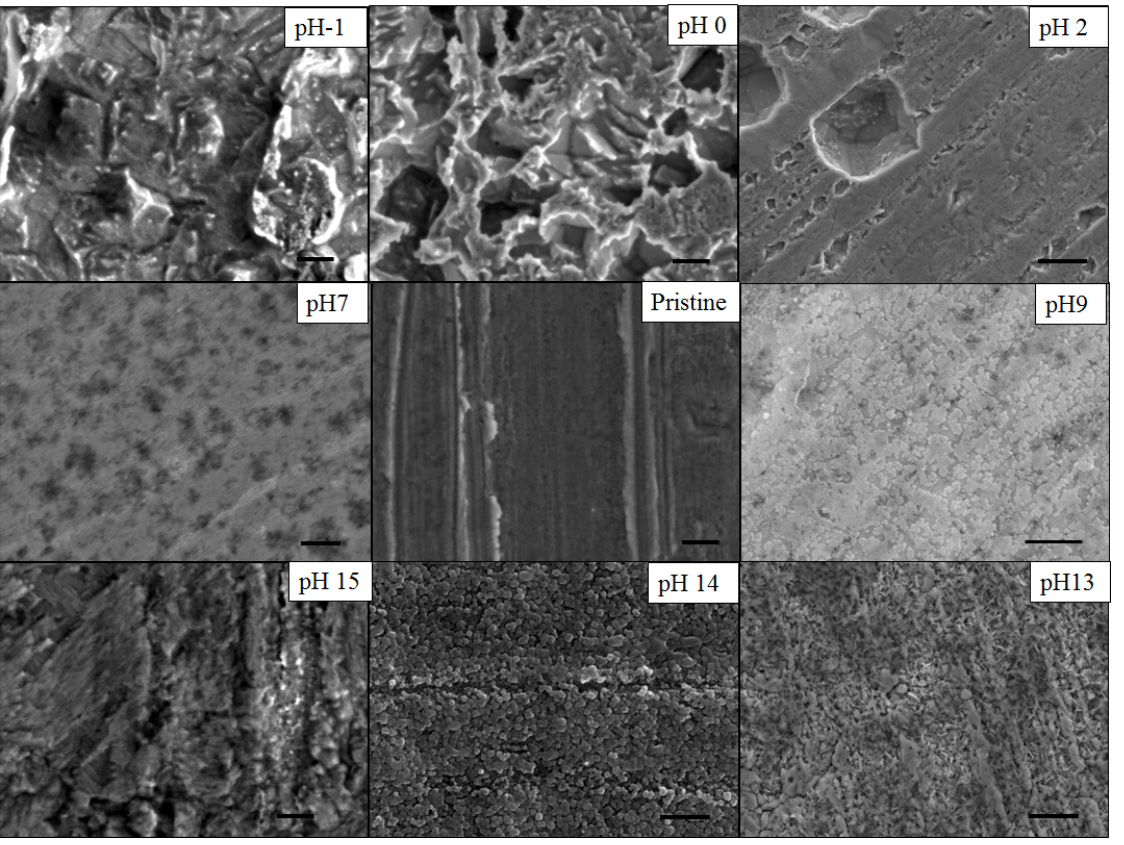
Figure 2. The scanning electron micrograph (SEM) images (in-plane view) of de-alloyed samples which de-alloyed with different etching solution (cross-section view has shown in Figures S2 and S3). 10 M HCl (pH = −1), 1 M HCl (pH = 0), 0.01 M HCl (pH = 2), deionized (DI) water (pH = 7), 1 × 10 −5 M NaOH (pH = 9), 10 M NaOH (pH~14), 1